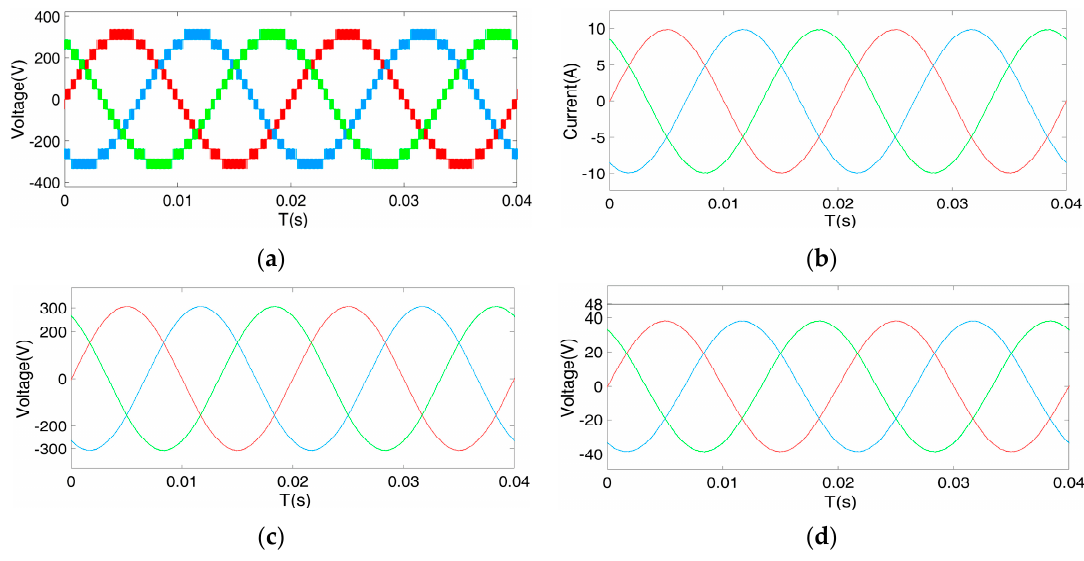
Figure 6. Waveforms for normal operation: the ( a ) three-phase converter output voltage; ( b ) grid current; ( c ) three-phase total reference signals; ( d ) three-phase sub-module modulating waveform.